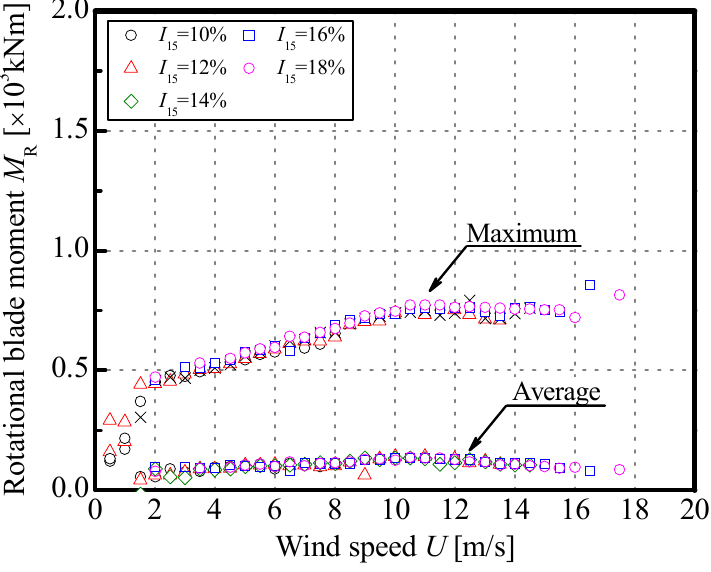
Fig. 9 Averaged and maximum blade root bending moment in rotational